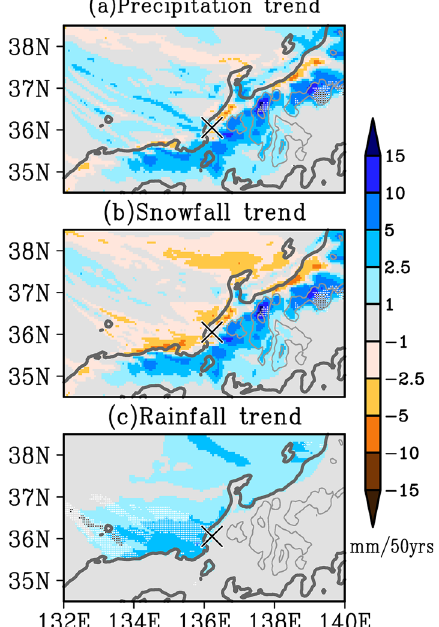
Fig. 12 Linear trends of a precipitation, b snowfall, and c rainfall when Sx1d is calculated by DS5km. White and black dots show statistically significant grids with 90 and 95% confidence levels, respectively. A cross mark represent the location of